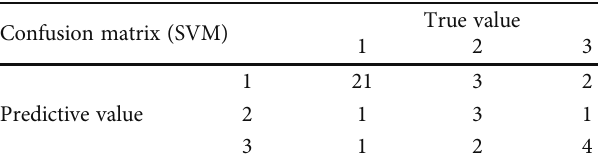
Table 7: Confusion matrix of optimized support vector machine algorithm for predicting ROP level.